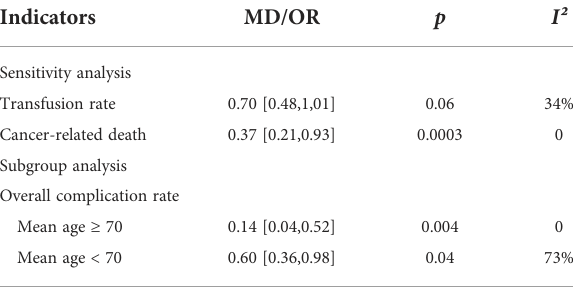
TABLE 4 The results of sensitivity or subgroup